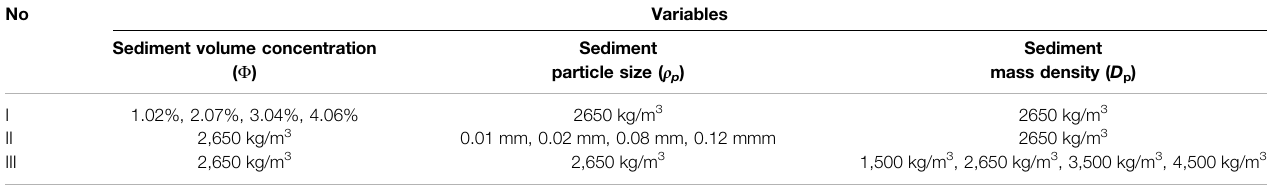
TABLE 2 | Parameters in the numerical